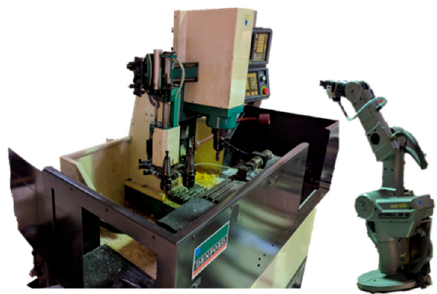
Figure 7. Milling machine and the robotic arm.